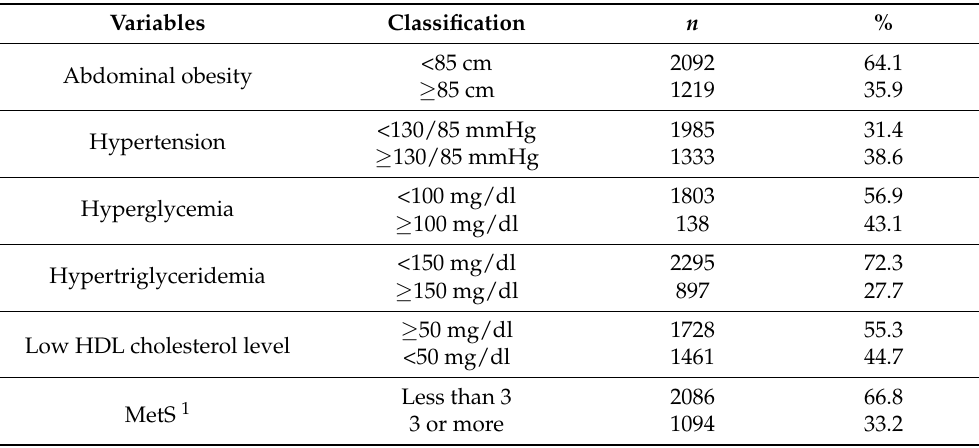
Table 2. Distribution of MetS and its components.